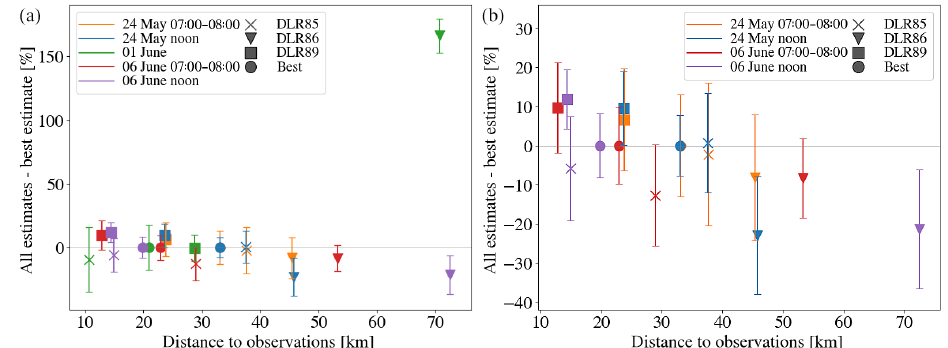
Figure 5. Relative differences between the best-estimate (weighted averaged) wind speed and sensitivity calculations using wind speed from individual wind lidars. Different colours represent different transects. Individual symbols refer to the wind information source used. The panel (b) is a zoom of the panel (a) , but it omits data from 1